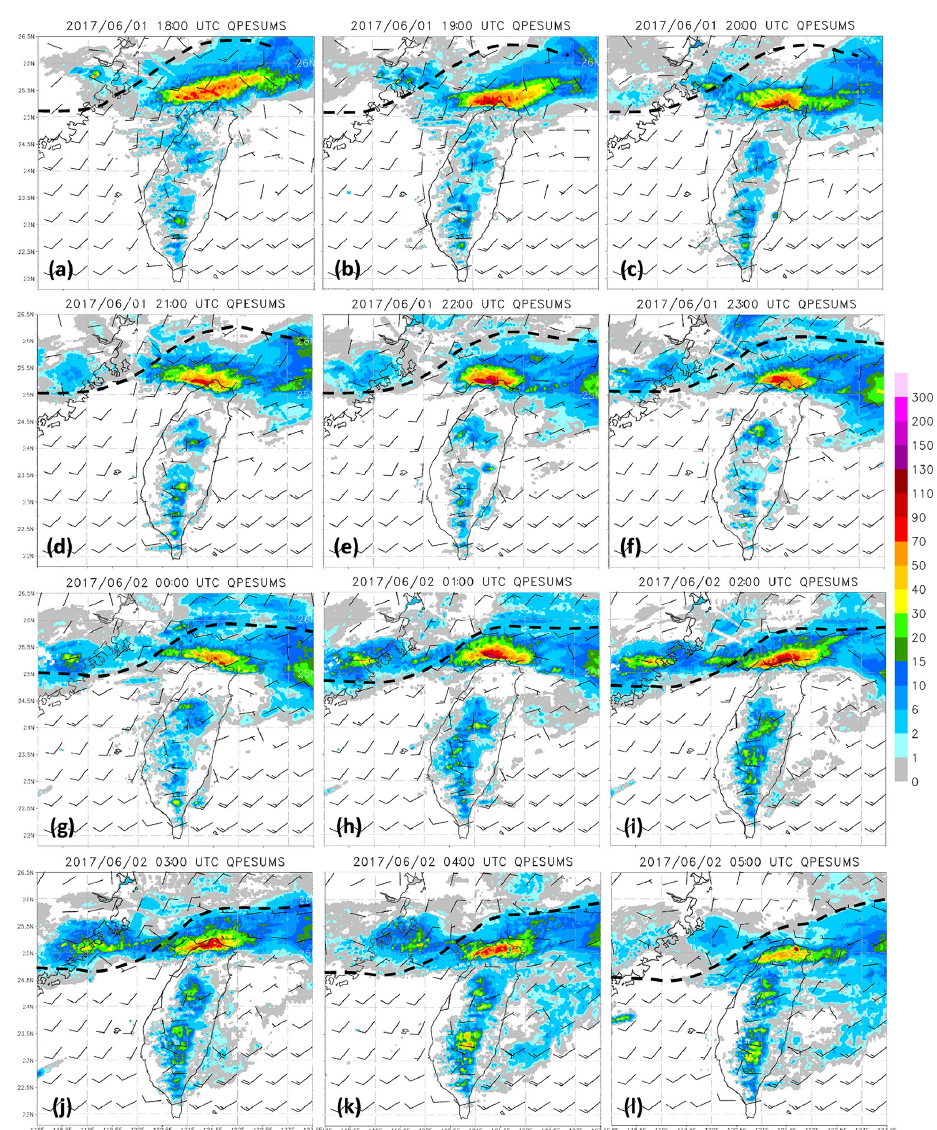
Figure 5. Hourly rainfall (mm) from the Quantitative Precipitation Estimation and Segregation using Multiple Sensors (QPESUMS), a radar- derived product merged with rain-gauge observations (source: CWB and the National Science and Technology Center for Disaster Reduction (NCDR) of Taiwan), overlaid with surface horizontal winds (barbs, 1 full barb = 10ms − 1 ) in the NCEP FNL analyses, surrounding Taiwan from (a) 18:00UTC on 1 June to (l) 05:00UTC on 2 June 2017. The wind fields between the 6-hourly FNL analyses are linearly interpolated in